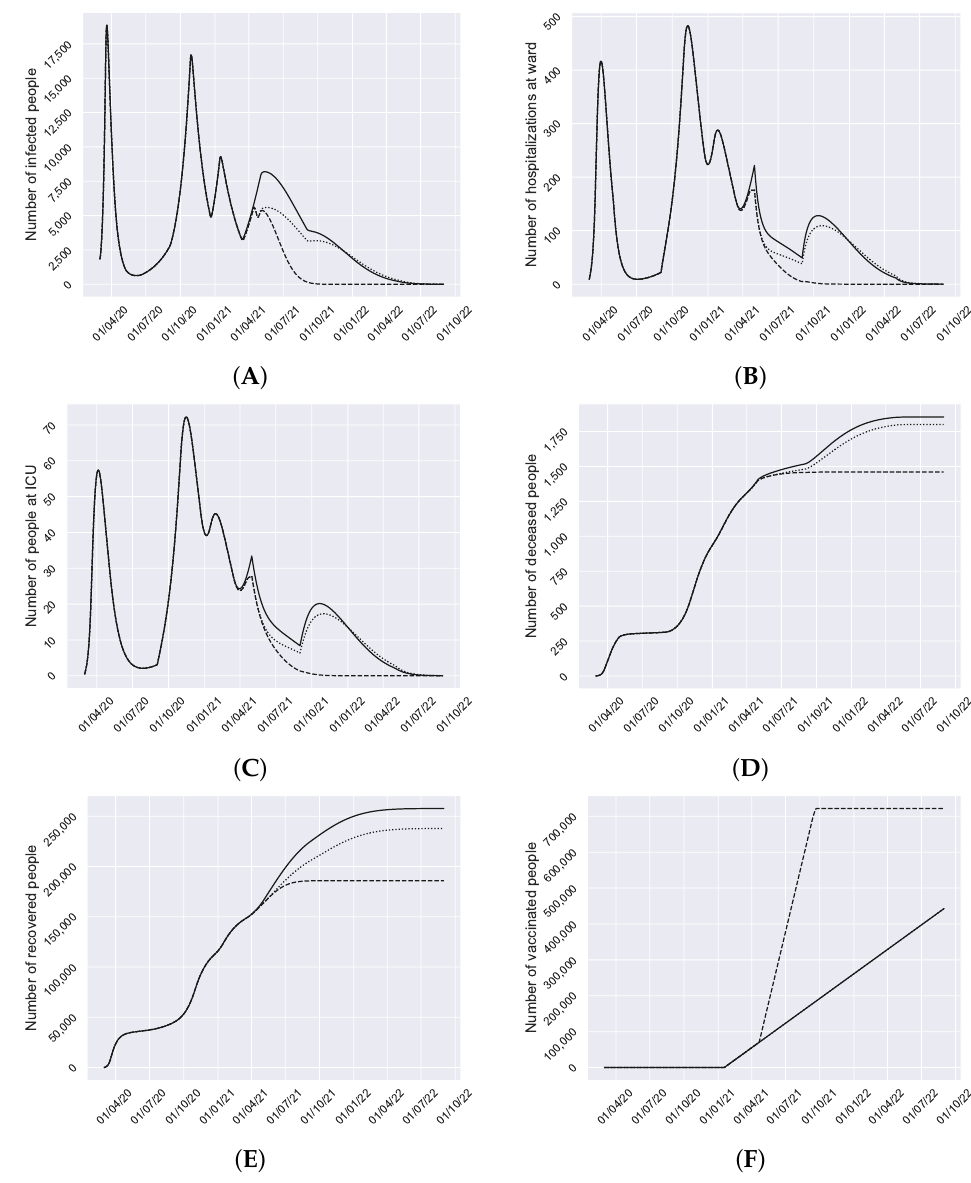
Figure 5. Average COVID-19 evolution in the three proposed scenarios with 70% of vaccine effective- ness. Scenario 1, continuous line. Scenario 2, dotted line. Scenario 3, dashed line. ( A ) Number of infected people. ( B ) Number of daily hospitalized at ward people. ( C ) Number of daily people in ICU. ( D ) Number of accumulated deaths. ( E ) Number of recovered people. ( F ) Number of vaccinated people. The wave in October 2021 in hospitalized and ICU appears because we are in the virulence season and the probability to be hospitalized or at ICU increases and the time to enter